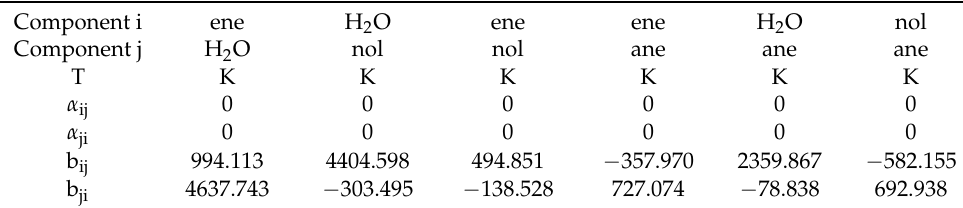
Table 1. NRTL model parameters.